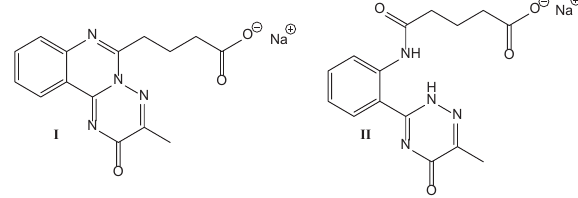
Figure 1. Chemical structures of quinabut ( I ) and impurity A ( II